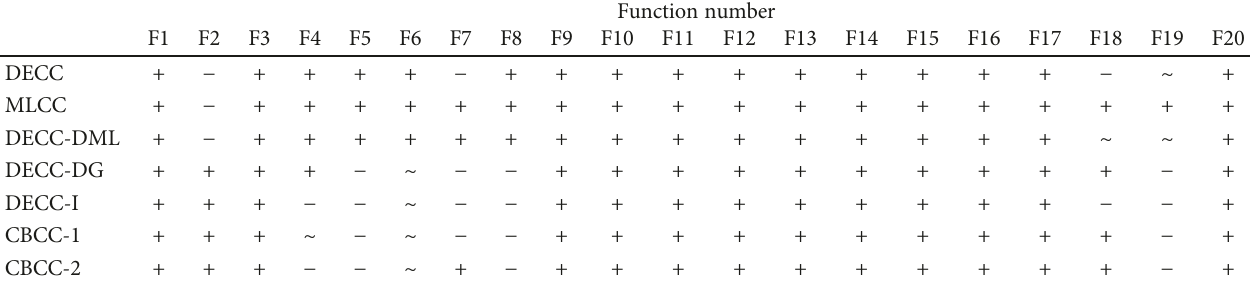
Table 4: Wilcoxon test with a signi fi cant level of 0.05. +, − , and ~ denote signi fi cantly better, signi fi cantly worse and not signi fi cantly di ff erent,